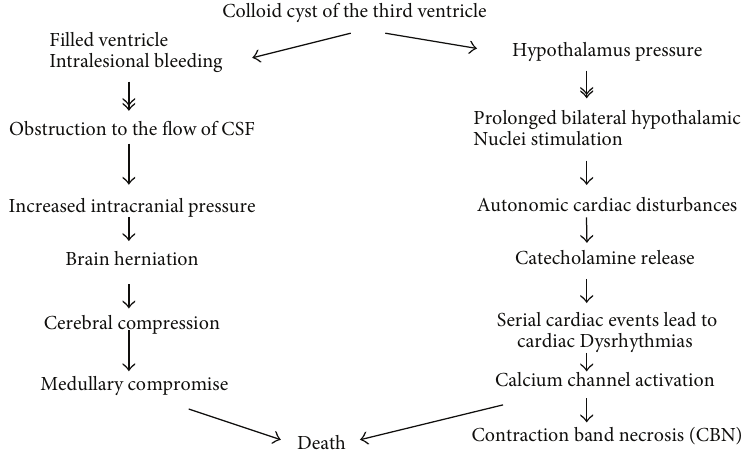
Figure 4: Mechanism of sudden death of patients with colloid cyst: hypothalamic structures which are involved in cardiovascular control are located close to the walls of the third ventricle which is most frequent anatomical site of the colloid cyst. It is adopted by Turillazzi et al.